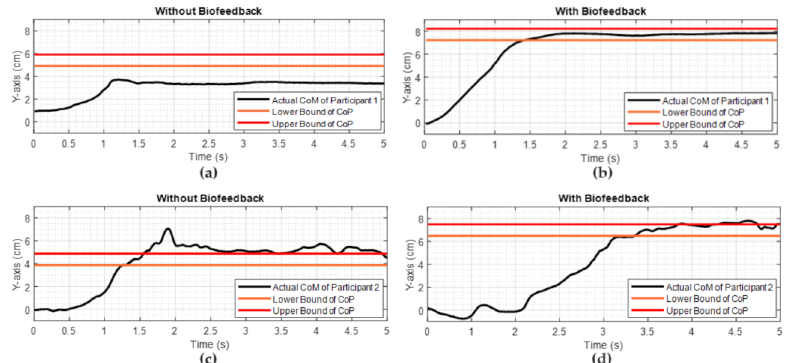
Figure 9. Reaching a desired CoP location experiments of two subjects: Participant 1 when received ( a ) no soft haptic biofeedback, ( b ) with biofeedback, and Participant 2 when received ( c ) no soft haptic biofeedback, ( d ) with biofeedback.